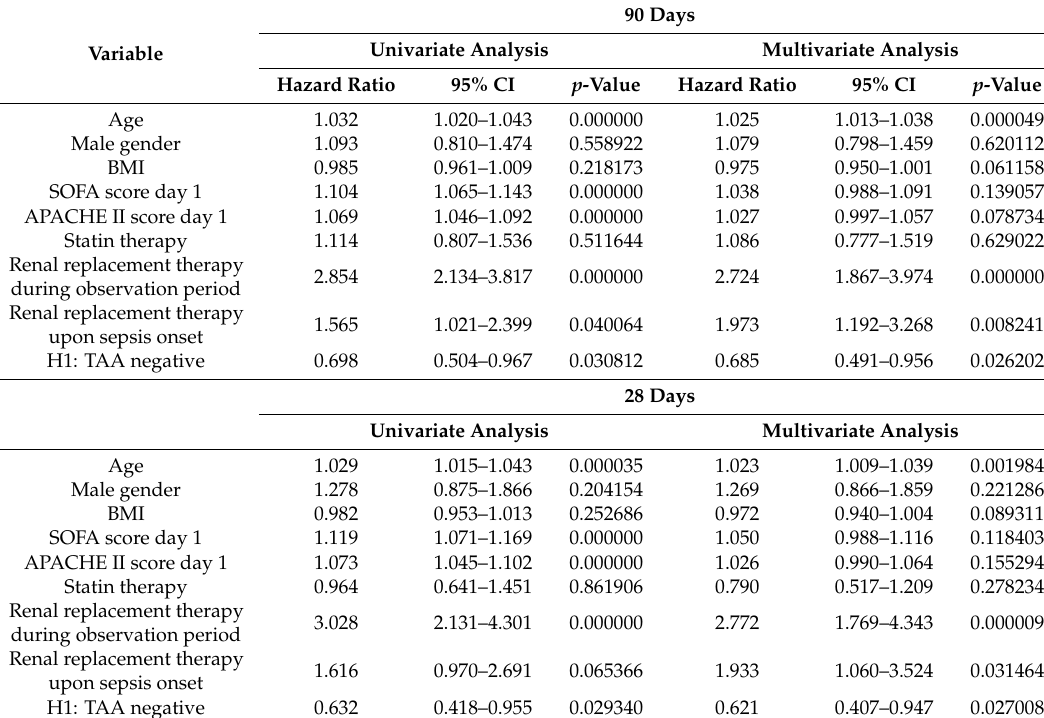
Table 5. Cox regression analysis with regard to the CTLA-4 haplotype H1: